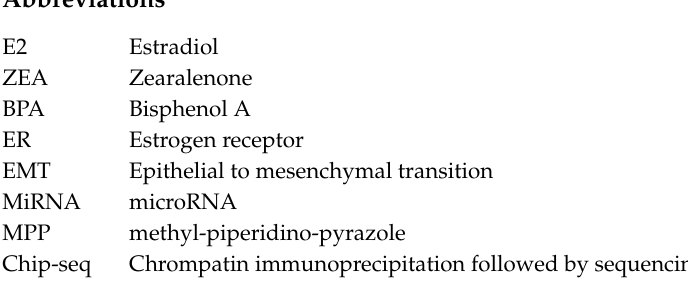
S.D. Figure S2. Relative fluorescence in response to E2, ZEA and BPA treatments in the PEO1 and A2780 cell lines. Fluorescence signal measured in the non-treated wells was regarded as 1. In the case of the positive